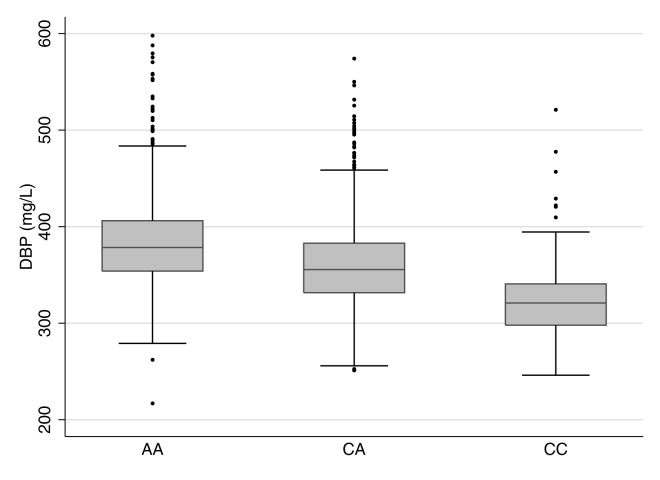
Boxplot of vitamin D binding protein levels by rs2282679 genotype.rs2282679 has three genotypes, i.e., AA, AC, and CC. Homozygous carriers of the major allele (AA) comprised 51.4% of the population, heterozygous carriers (AC) comprised 39.6%, and homozygous carriers of the minor allele (CC) comprised 9.0%. Individuals carrying the effect allele, C, had lower DBP levels than those with the more common allele (AA: 384.6 mg/l [SD 48.3], n = 1,159; CA: 360.7 mg/l [SD 45.9], n = 893; CC: 322.9 mg/l [SD 39.1], n = 202). The effect allele showed an inverse linear relationship with DBP levels.